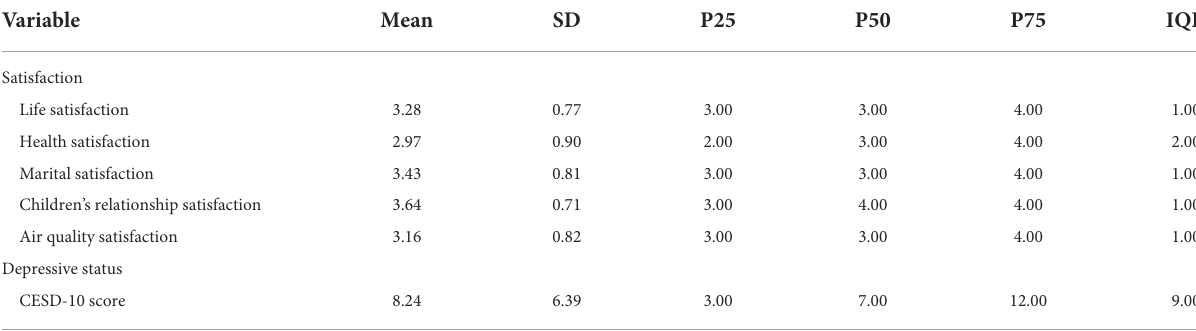
TABLE 2 Self-reported satisfaction and depression score of participants.